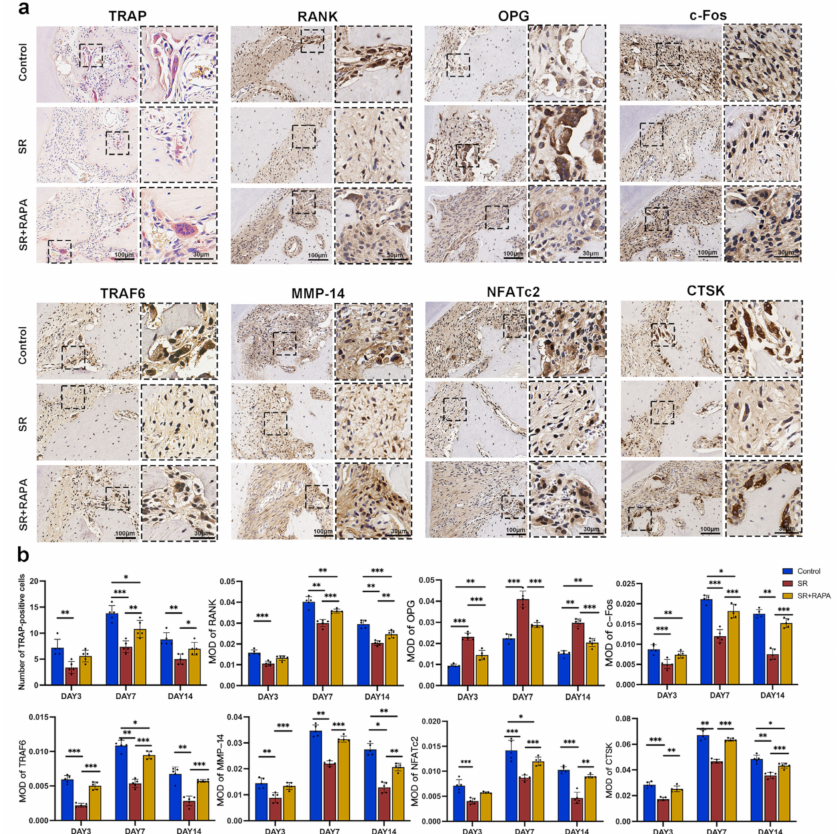
Figure 4. Strontium ranelate inhibited osteoclast differentiation and the expression of osteoclast markers in rats. ( a ) TRAP staining images of osteoclasts and immunohistochemical staining images of RANK, OPG, c-Fos, TRAF6, MMP-14, NFATc2, and CTSK at the pressure side of the first molars on day 7 in different groups. ( b ) Number of osteoclasts and the mean optical density (MOD) of RANK, OPG, c-Fos, TRAF6, MMP-14, NFATc2, and CTSK at the pressure side of the first molars on days 3, 7, and 14 in different groups. (n = 5, mean ± SD, * p < 0.05, ** p < 0.01, *** p < 0.001). SR also downregulated the MOD and MFI of autophagy-related proteins, including Beclin1, ATG5, LAMP2, and LC3, while it enhanced the MOD and MFI of p62 at the